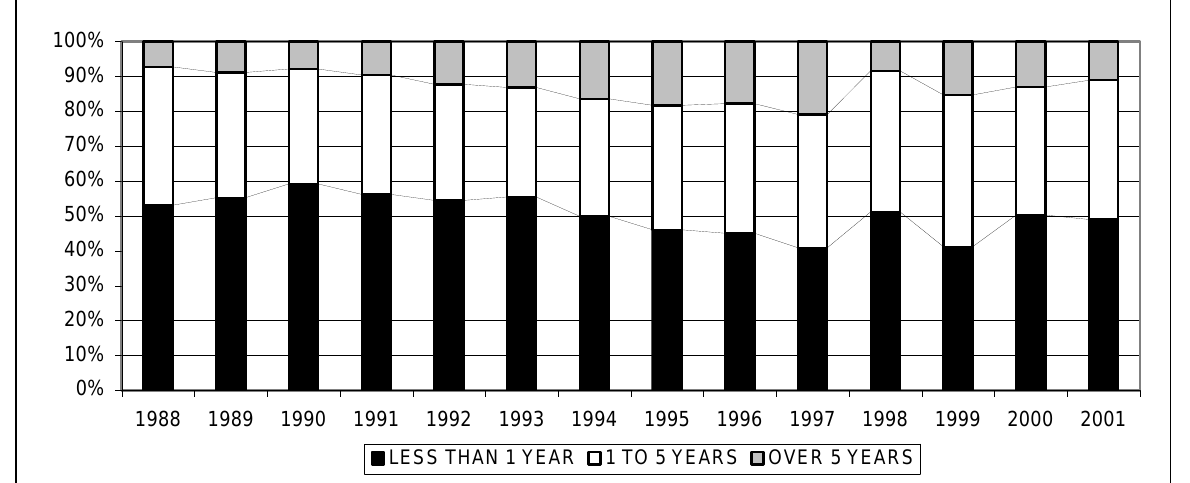
Share of advances by maturity in total outstanding advances